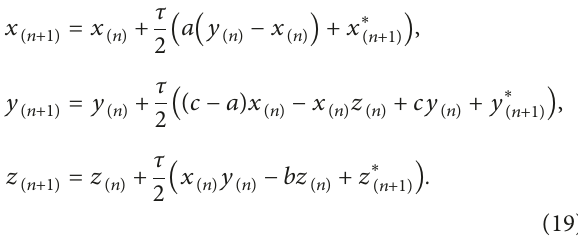
Figure 11: Implementation of ES in V2 of Liu and Chen CS (16) in its DV. (a) Phase plane x x ( n ) and z ( n ) .